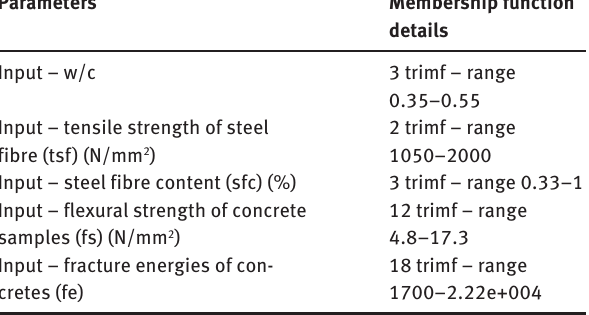
Table 2 Details of chosen parameters for FL